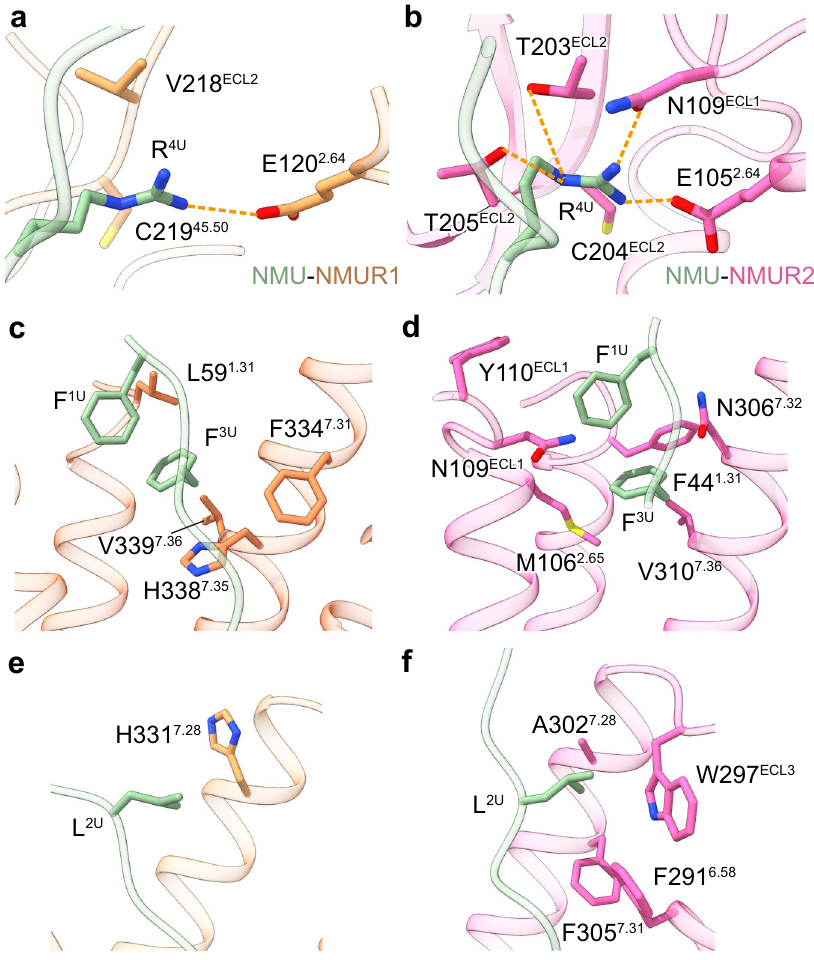
Fig. 3 Comparison of the binding mode L 2 -F 3 -R 4 in NMU between NMUR1 and NMUR2. Detailed interactions between R 4U ( a , b ), F 3U ( c , d ), and L 2U ( e , f ) and pocket residues in NMUR1 and NMUR2 are shown. Sidechains of residues are displayed in sticks. Hydrogen bonds and salt bridges are depicted as orange dashed lines. NMU is displayed in green, NMUR1 in brown, and NMUR2 in hot